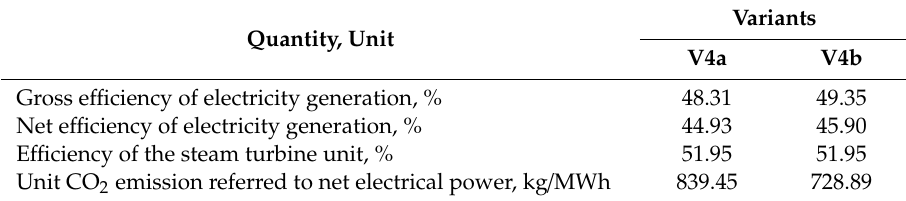
Table 8. The thermodynamic quantities determined for the reference power